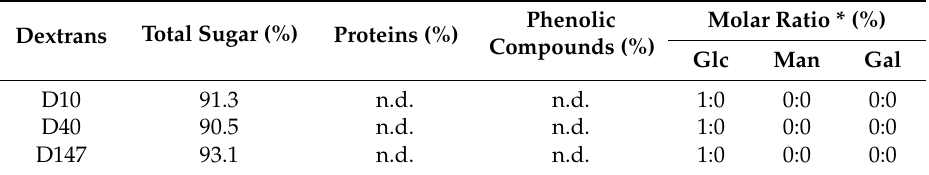
Table 1. Chemical composition of the D10, D40 and D147 dextrans. Dextrans Total Sugar (%) Proteins (%)